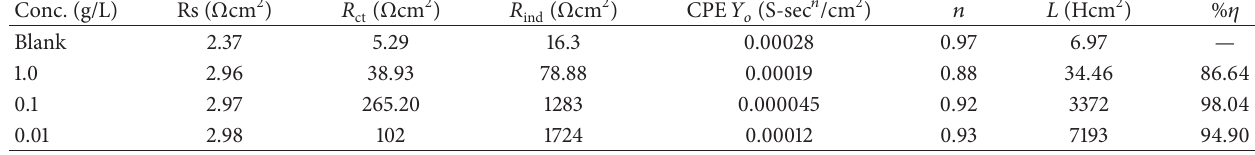
SO with and without various concentrations of BO extract. 2 4